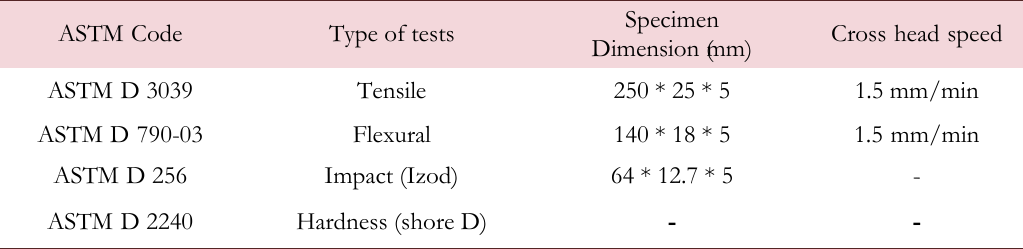
Table 1: ASTM Standards followed for mechanical properties evaluation